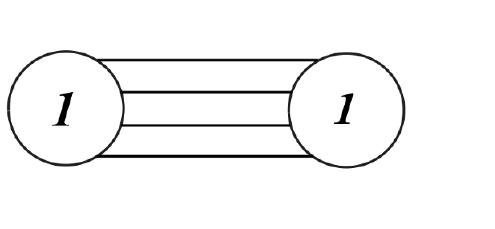
Figure 1. Left: the a(cid:14)ne A 1 Dynkin diagram. Right: the nilpotent cone of Hitchin (cid:12)bration for f M 2 ; 1 , consisting of two C P 1 intersecting at O with intersection number 2. Together with P 1 , P 2 , they comprise the three (cid:12)xed points of the Hitchin moduli space f M 2 ; 1